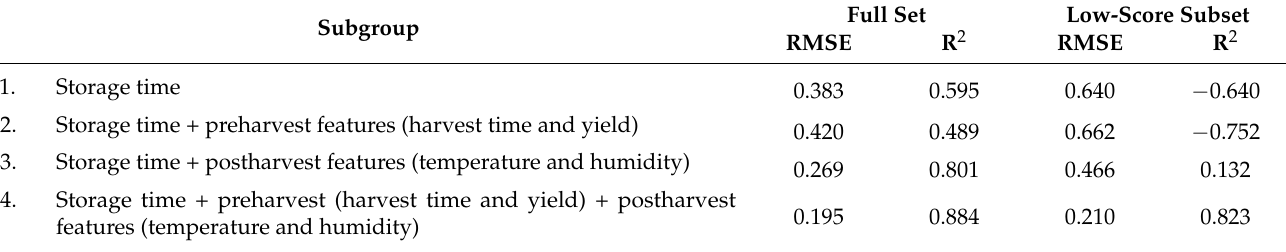
Table 5. The RMSE and R 2 values for the Non-linear SVR regression model with three duplications for the full set and low-score subset using four different feature